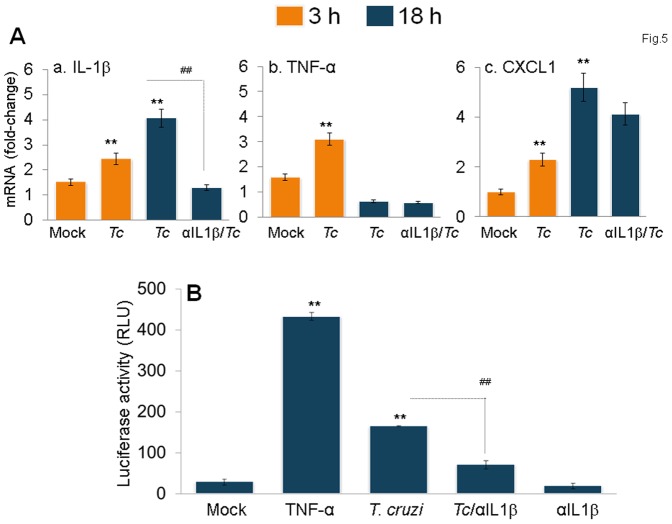
IL-1β signals NF-κB activation and inflammatory cytokine gene expression in infected mφs.
(A) The mRNA levels for IL-1β (panel a), TNFα (panel b) and CXCL1 (panel c) cytokines were measured in T. cruzi-infected THP-1 mφs at 3h and 18h pi by quantitative RT-PCR. (B) RAW 264.7 macrophages were transiently transfected with pGL4.NF-κB-Luc reporter plasmid and pREP7-Rluc plasmid (transfection efficiency control) as described in Materials and Methods. Transfected cells were infected with T. cruzi and incubated in the presence or absence of anti-IL-1β antibody. Mφs incubated with 10 ng/ml recombinant TNF-α for 6 h were used as positive controls. The relative NF-κB transcriptional activity was measured by firefly luciferase activity and normalized to Renilla luciferase activity. The transcriptional activity of NF-κB in normal cells was considered as baseline and valued at 1.